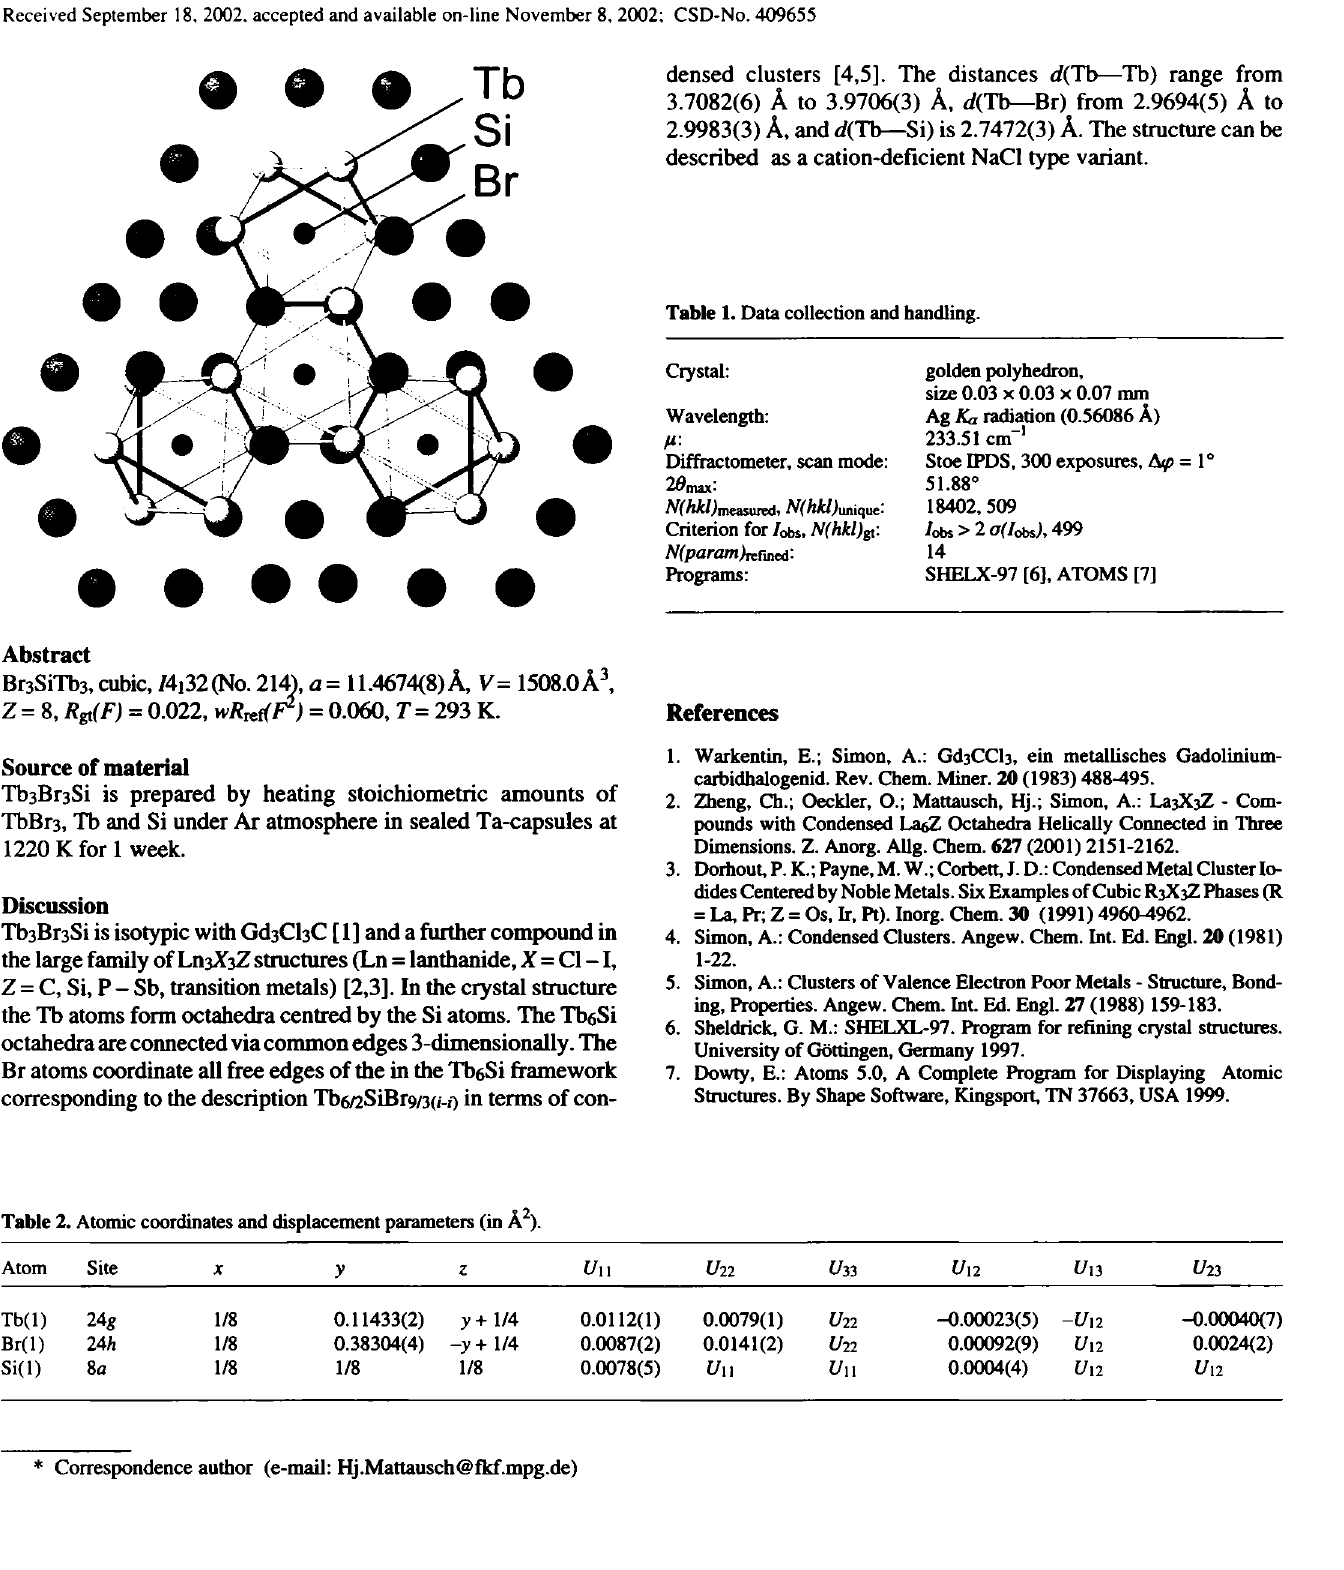
Table 1. Data collection and handling.